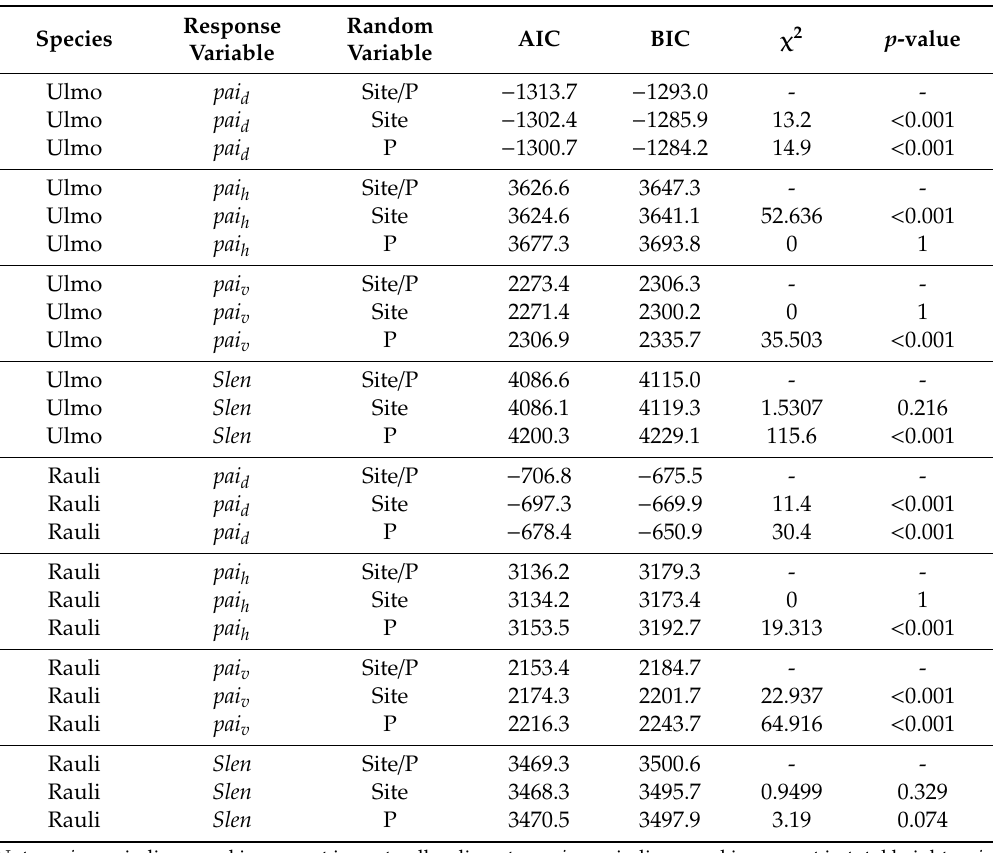
Table A1. Restricted estimated maximum likelihood (REML) after a stepwise selection. Comparison between the best-supported models for each response variable (in bold) with those of the same structure in the fixed terms, with variation in the structure of the random terms. The (site / P) notation illustrates the nestedness of plots (P) within a site